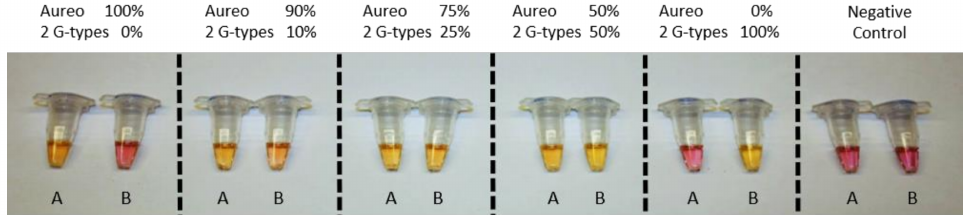
Figure 6. Colorimetric detection of a complex adulteration of Aureo with two G-type wheat variants. LAMP reactions with loop primer T (tube A) and loop primer G (tube B) were all performed at 63 ◦ C for 1 h. From left to right, targets were composed of 100% Aureo variant, then mixtures of Aureo and two G-type variants (Babylon + Marco Aurelio) with a total contamination from 10 to 100%, and a negative